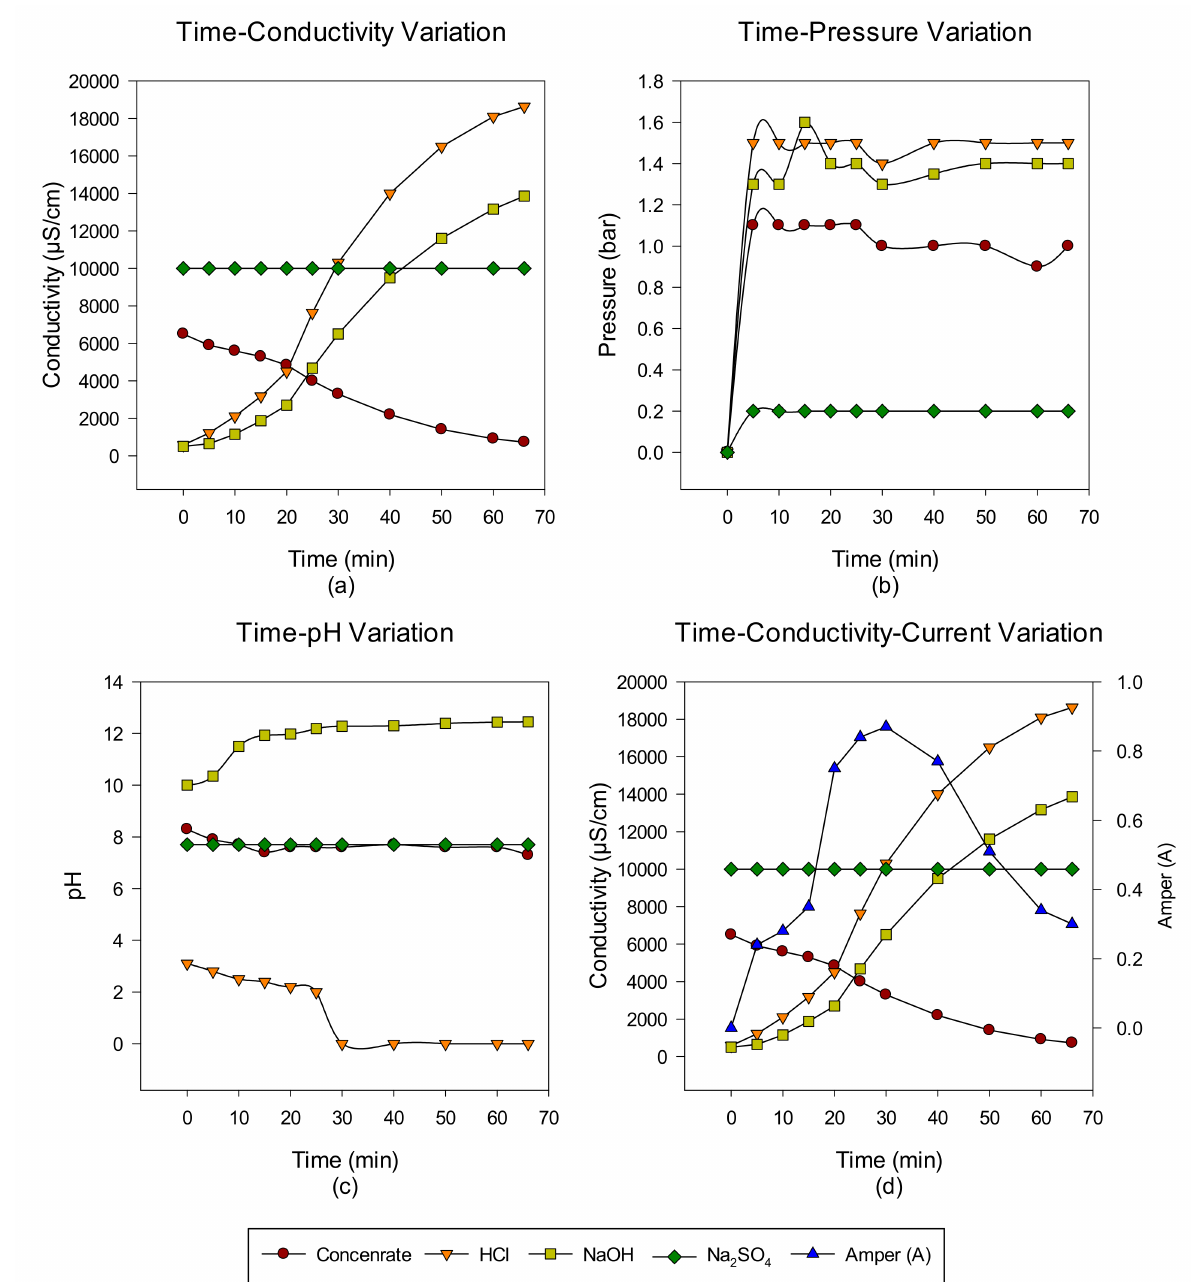
Figure 3. NaCl–NaOH–HCl–Na 2 SO 4 ( a ) conductivity, ( b ) pressure, ( c ) pH, and ( d ) conductivity and ampere change between 0 and 66